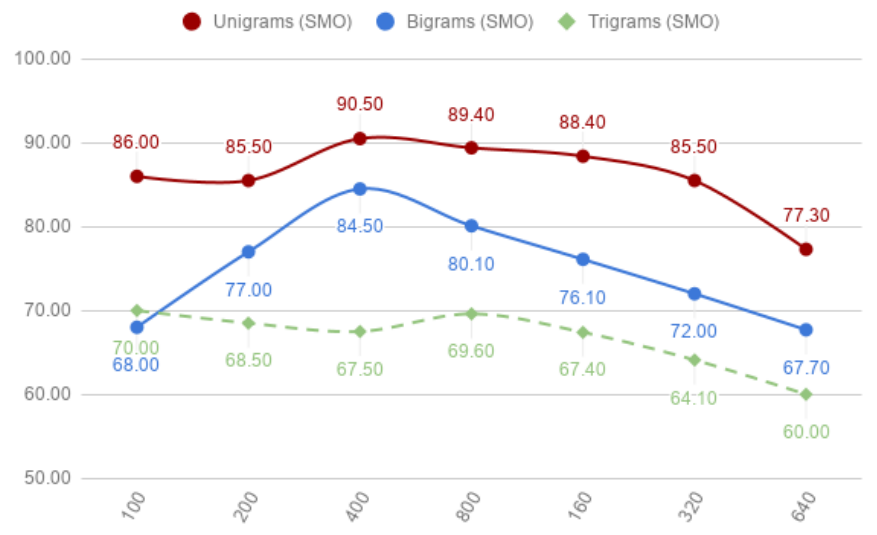
Figure 4. Word-grams: unigrams, bigrams and trigrams of random-forest (RF) classifier per corpora.